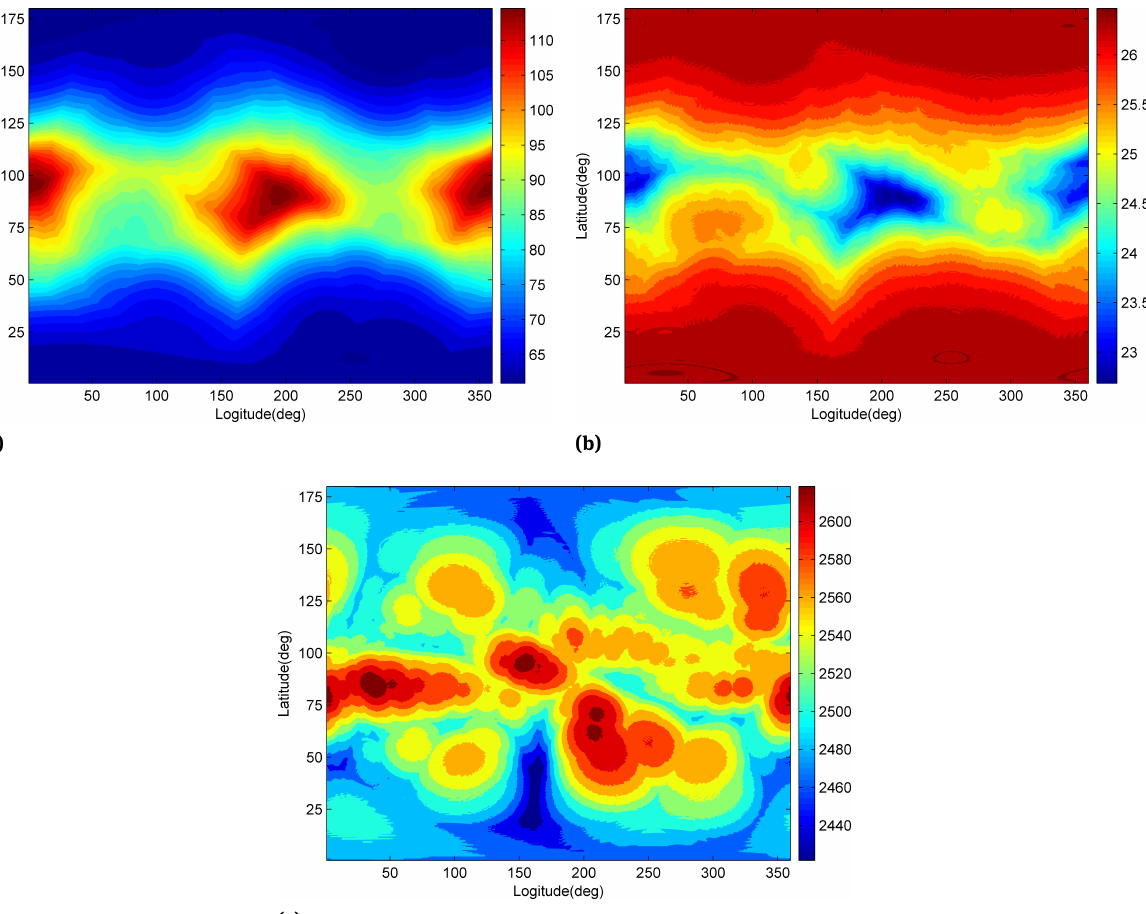
Figure 2. Contour plot of the surface parameters of 45 Eugenia. (a) Surface height on the surface; (b) Gravitational force on the surface; (c) Effective potential on the